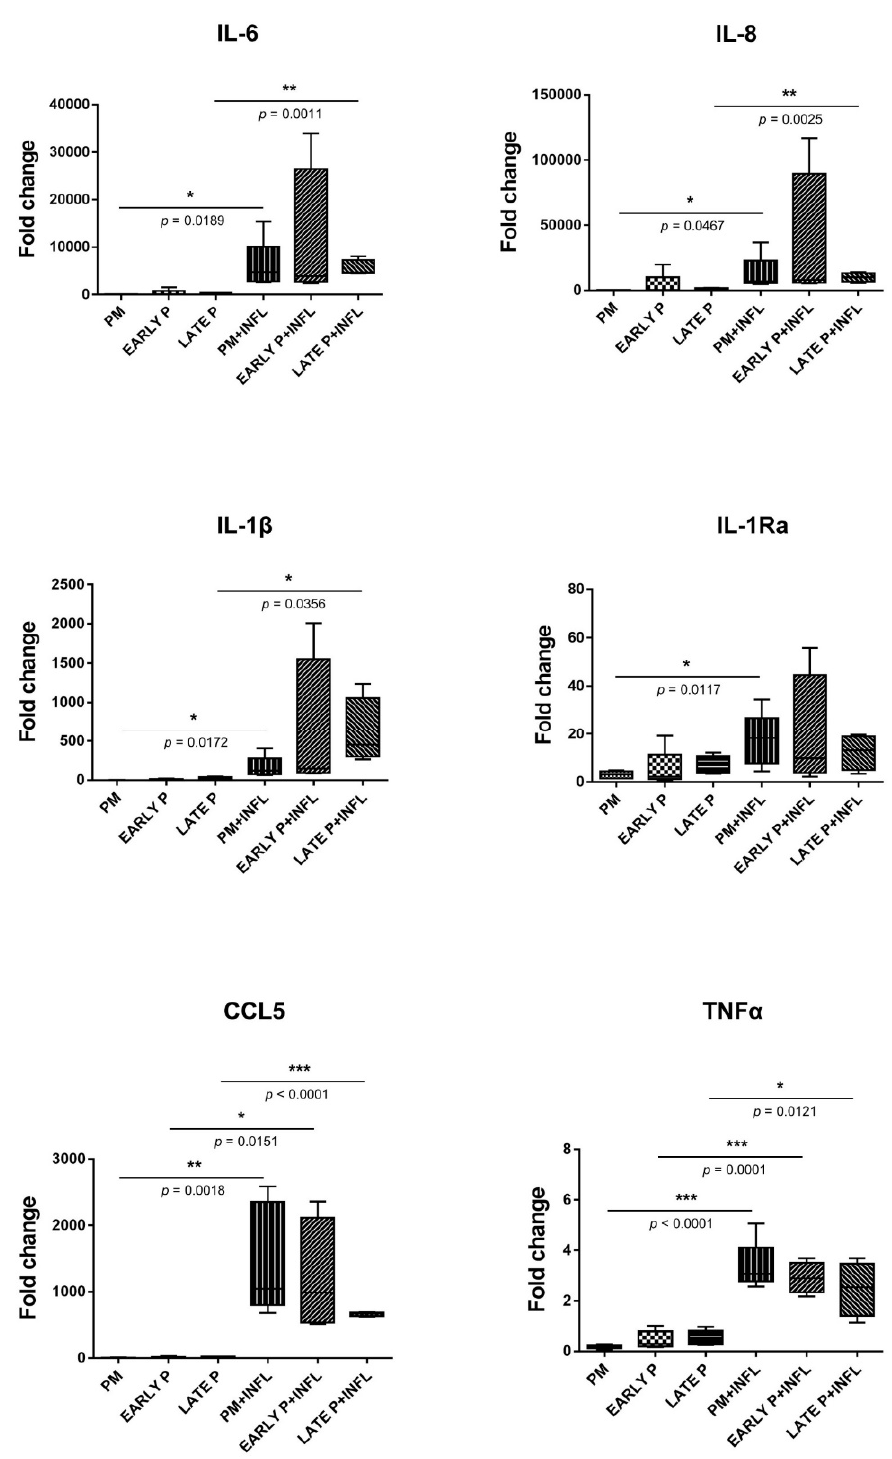
Figure 4. The expression of cytokines is upregulated in MSCs. The gene expression level of each cytokine is determined by qPCR analysis from basic MSCs and inflamed MSCs (INFL) during the primo culture (PM), early (EARLY) and late (LATE) passage (P). The values are expressed as mean ± SEM compared to the expression of the housekeeping gene (ACTB and GAPDH). *, **, *** Significant increase of expression of inflamed MSCs (INFL) versus basic MSCs ( p -value: p ≤ 0.05, p ≤ 0.01, p ≤ 0.001,